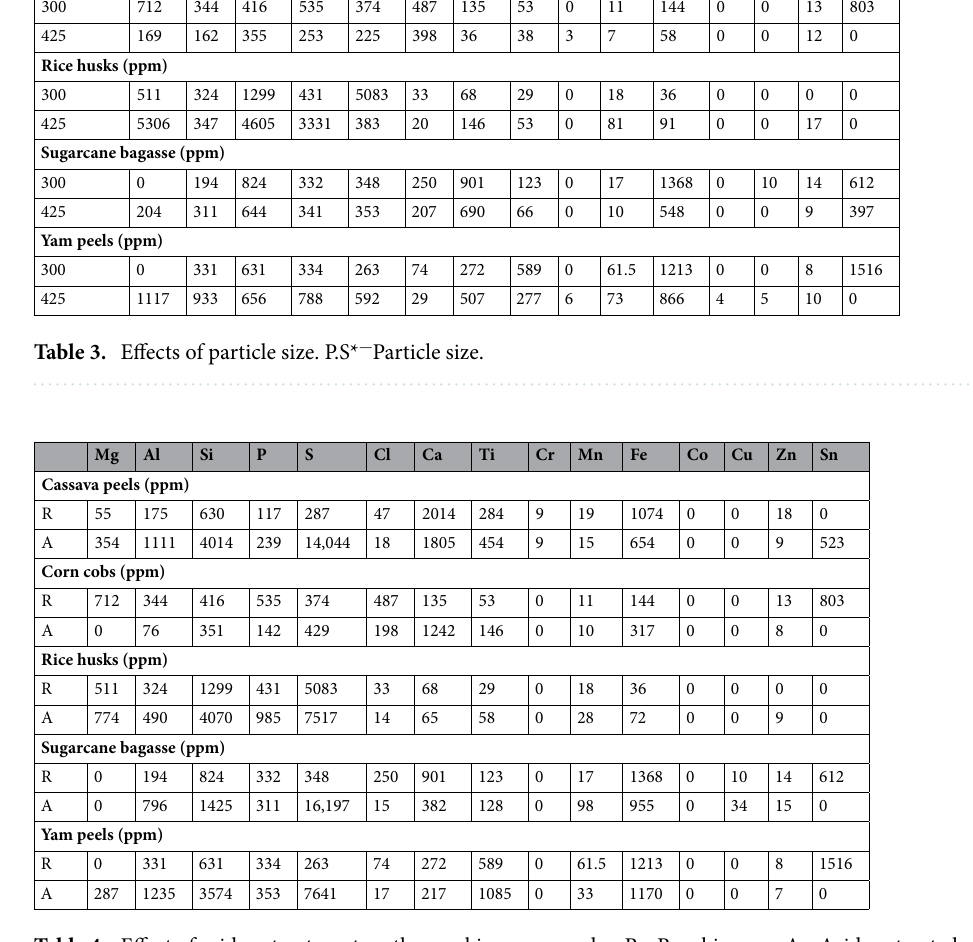
Table 4. Effect of acid pretreatment on the raw biomass samples. R = Raw biomass. A = Acid pretreated